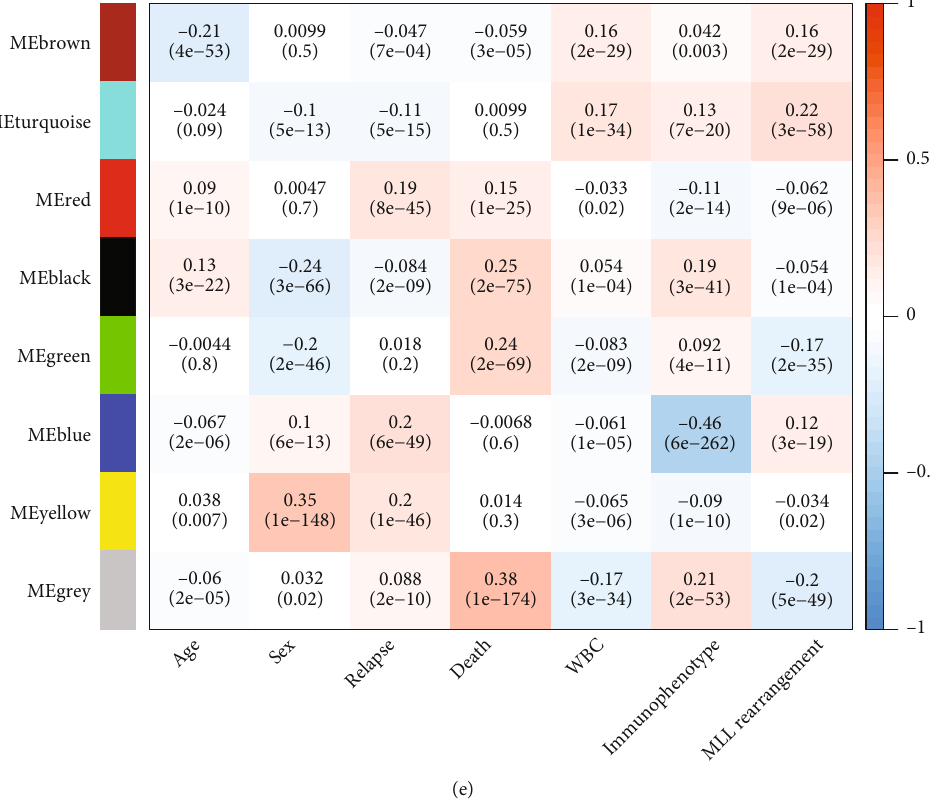
Figure 3: Clustering dendrograms of gene modules screened from the datasets TARGET (a), GSE28460 (b), GSE17703 (c), and GSE60926 (d) and the association between functional modules of RNAs in the TARGET dataset and the clinical characteristics of acute lymphoblastic leukemia patients (e). In the module-trait heat map, each column corresponds to clinical parameters and each row corresponds to a module eigengene. The correlation coe ffi cients are shown at the top of each row. The corresponding p values for each module are displayed at the bottom of each row within parentheses. WBC: white blood cell; MLL: mixed lineage